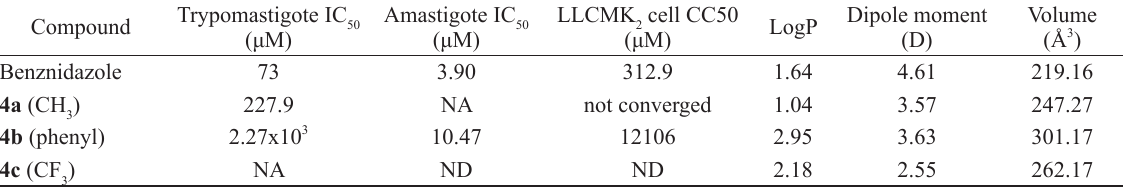
NA = not active, ND = not